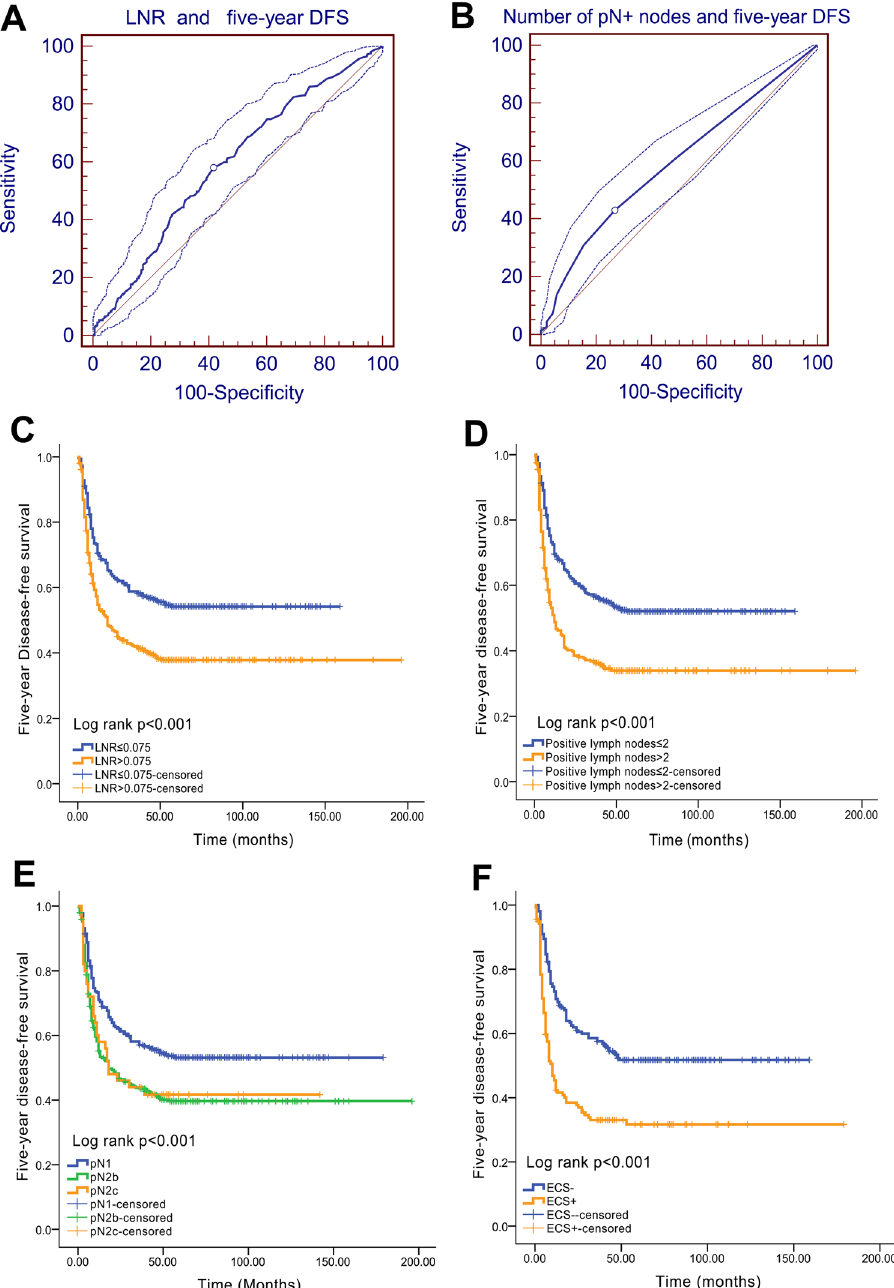
Figure 1. Best cut-off values for nodal parameters and 5-year DFS. ( A ) ROC curve analysis of the LNR cut-off value and 5-year DFS (the cut-off value for the LNR is 0.075); ( B ) ROC curve analysis of the number of positive lymph nodes and 5-year DFS (the cut-off value for the number of positive lymph nodes is 2). ( C ) Five-year DFS curve for the LNR; ( D ) 5-year DFS curve for the number of positive lymph nodes; ( E ) 5-year DFS curve for the pN stage; ( F ) 5-year DFS curve for the ECS